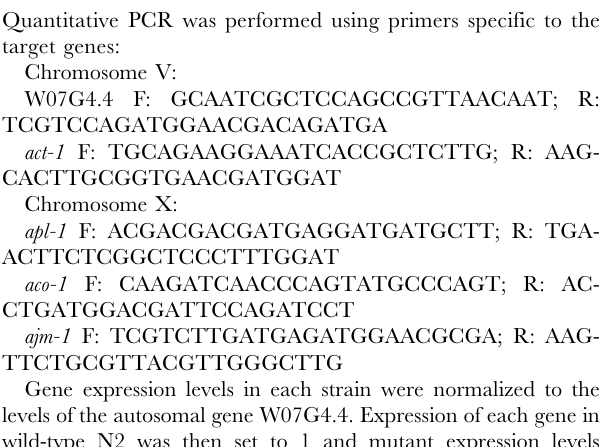
Figure S2 H4K20me1 enrichment on the X chromosome in